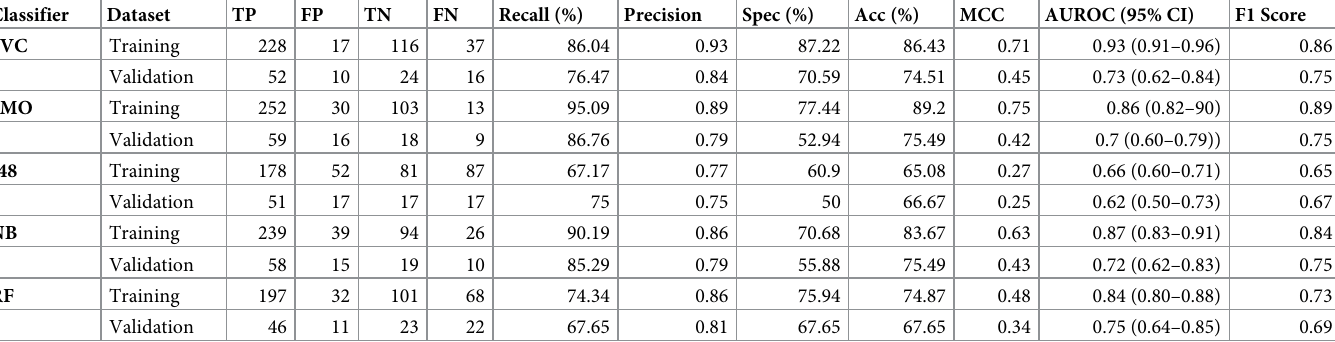
Table 2. The performance measures of the prediction models developed based 36-full feature set (THCA-EL-SVC-L1) selected by SVC-L1 on training and validation dataset by implementing various machine-learning algorithms. Classifier Dataset